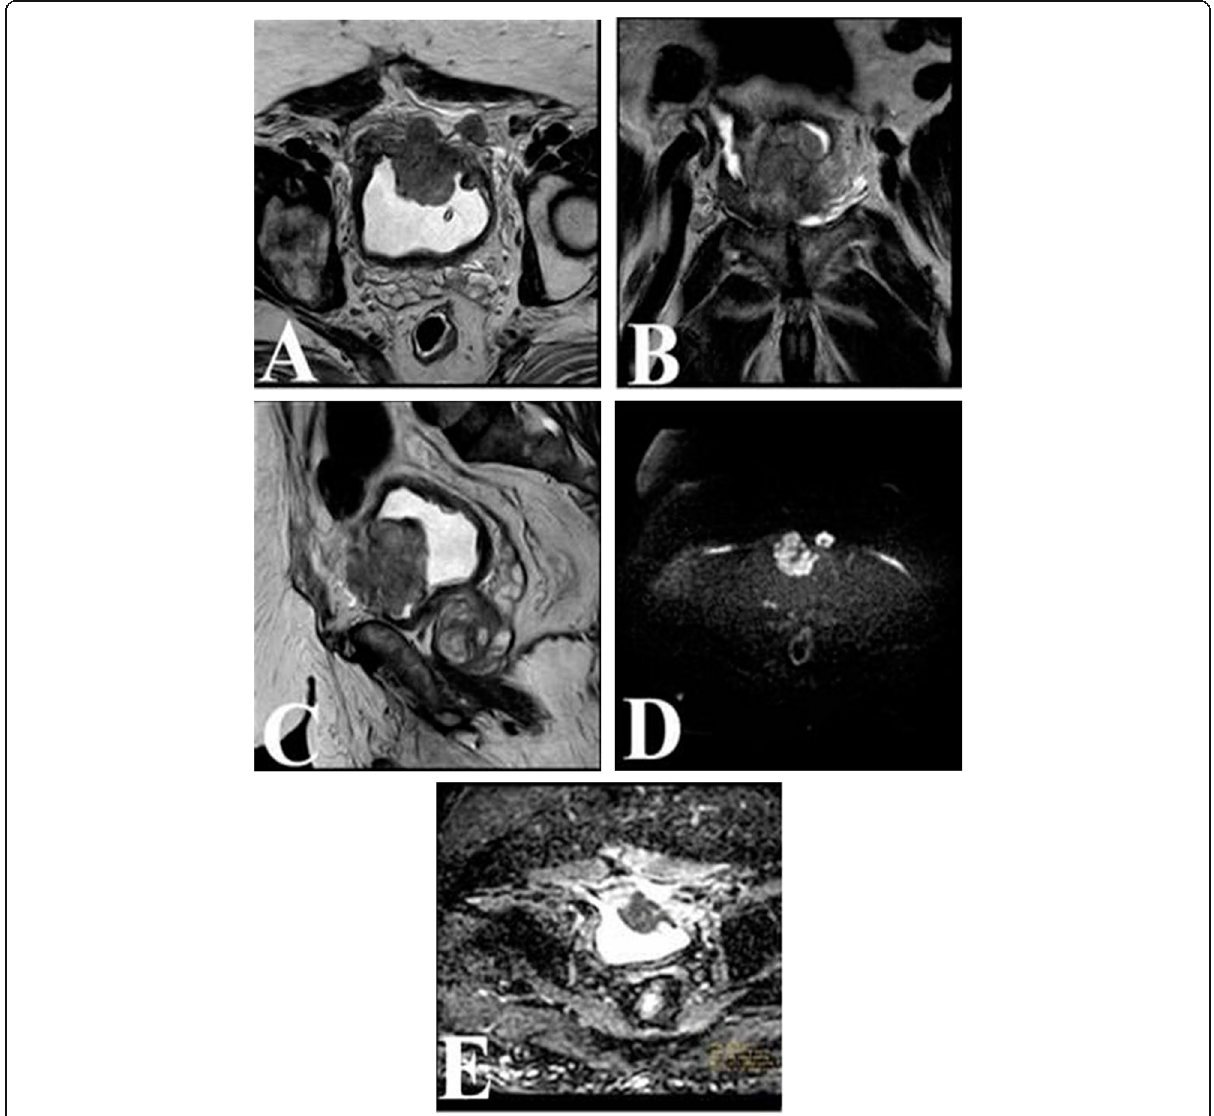
Fig. 6 An intravesical soft tissue mass is seen arising from anterior wall with infiltration of anterior peritoneal reflection and anterior abdominal wall on T2 WI, seems separable from anterior abdominal wall muscles on DWI. a axial HR T2 image, b coronal HR T2 image, c sagittal HR T2 image, d axial DWI (b 1400) image, and e Axial ADC map with ADC measured within lesion (0.71 × 10 − 3 mm 2 /s). Pathologically proved urothelial cancer, T4, GIII